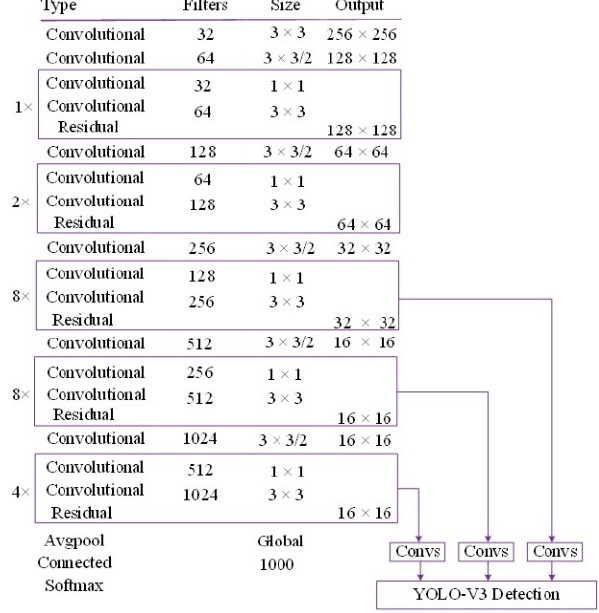
Figure 3. The structure of YOLO V3.